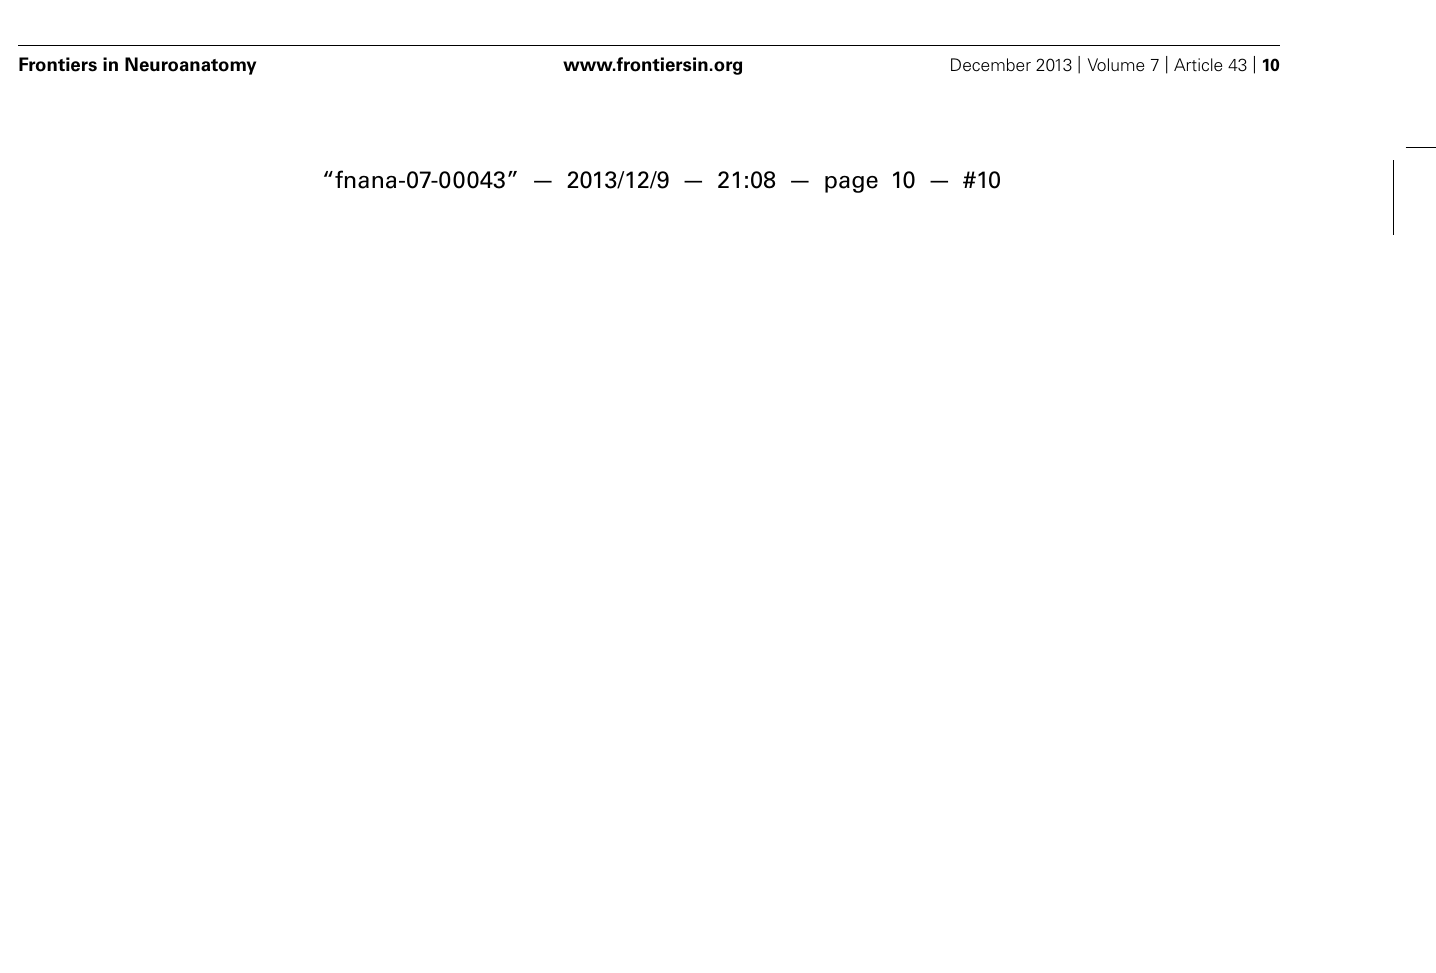
lateral hypothalamus (LHt), and the mammillary part of lateral hypothalamus (LHm) after AcbC, medial AchSh, and ventral AcbSh injection, respectively. Arrowheads indicate varicosities. Scale bar = 100 μ